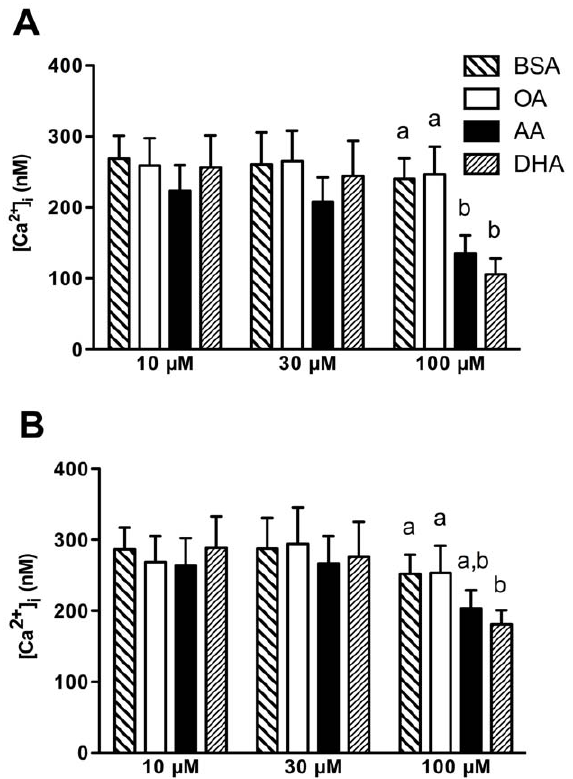
Figure 3. The change in [Ca 2 + ] i of PHM1-41 cells in response to 25 nM oxytocin. The response of all cells are shown in (A) and cells unresponsive to oxytocin stimulation are excluded from the analysis in (B). Data are expressed as the mean peak increase in [Ca 2 + ] i per dish. Values are mean 6 SEM (n=7 experiments at 10 m M and 30 m M; n=12 experiments at 100 m M). Bars not sharing common letters are significantly different between treatment groups, p , 0.05. doi:10.1371/journal.pone.0041708.g003 [70]. In the present study, PHM1-41 membrane DHA composed 6.7 6 0.5% of total fatty acids with 30 m M DHA treatment and 10.2 6 0.5% with 100 m M DHA treatment. Relative proportions of